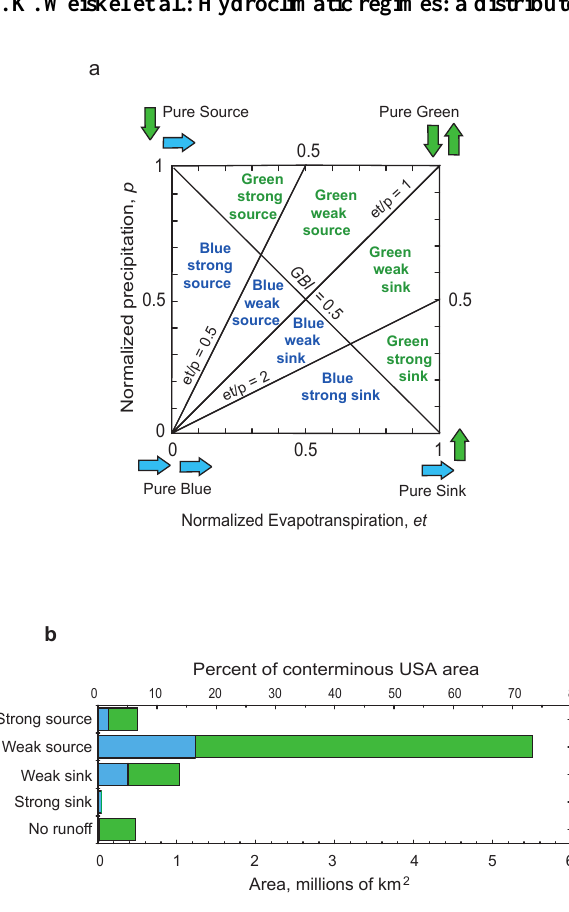
Figure 4. (a) Hydroclimatic regime classification, based on in- dicators of local climate (hydrologic-unit-evapotranspiration ratio, et /p ) and relative magnitude of green and blue fluxes (GBI); (b) ar- eas of the conterminous USA covered by regime classes of (a) , and by area considered to have zero runoff (0.99 < et /p < 1.01).